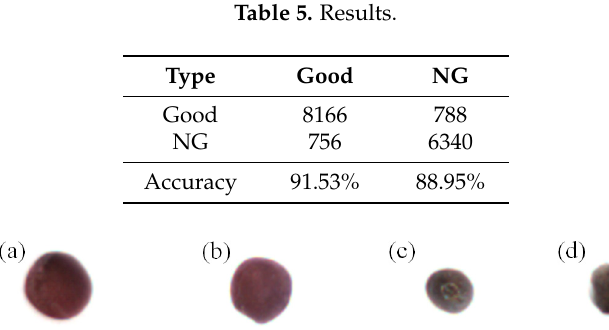
Figure 11. Size: ( a ) excellent; ( b ) excellent; ( c ) small; ( d ) small.